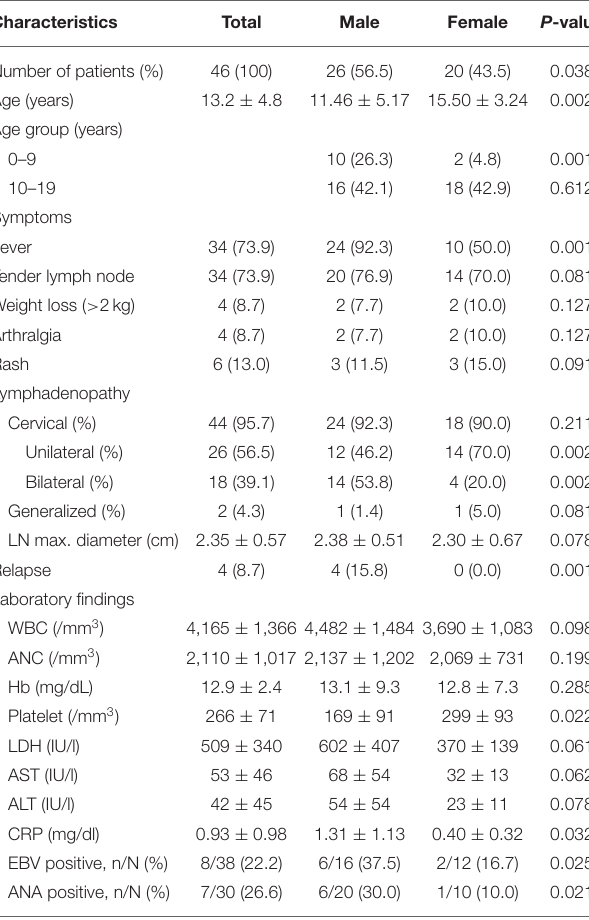
TABLE 2 | Manifestations of Kikuchi-Fujimoto disease in children by sex.